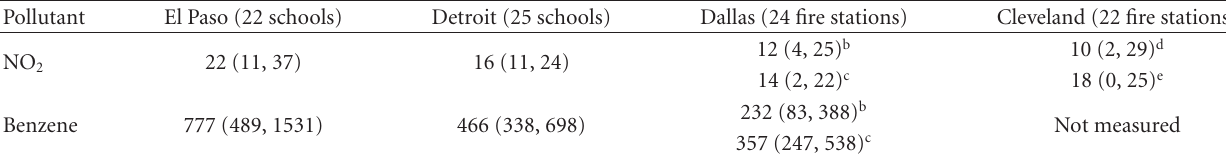
Table 2: Median pollutant concentrations (all above method detection limits) in the four cities a .